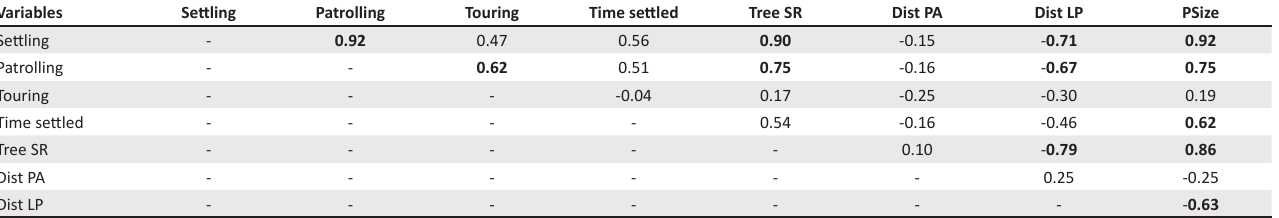
TABLE 4: A rank correlation matrix of Spearman rank correlations ( r across all sites ( n = 11). Variables